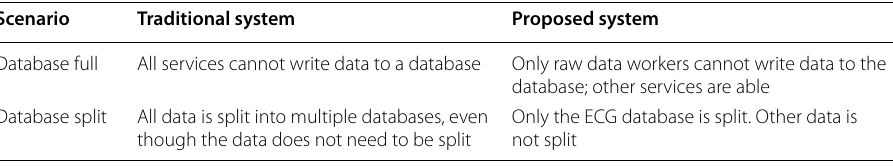
Table 5 System scalability summary